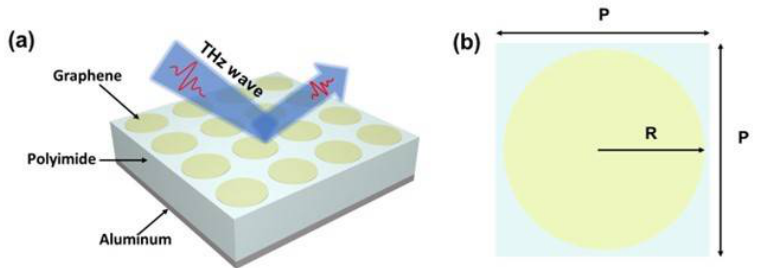
Figure 1. ( a ) Schematic of the proposed absorber based patterned graphene metamaterials. ( b ) Top view of unit cell.